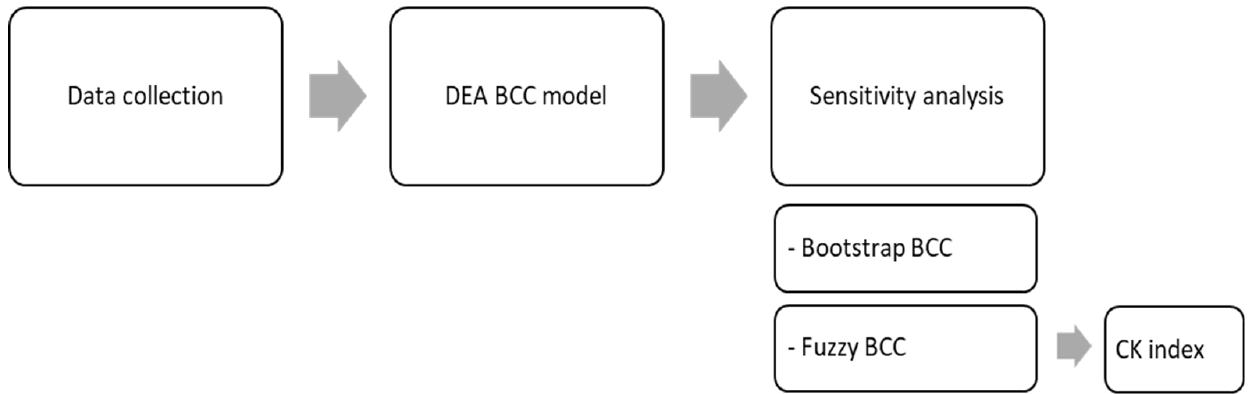
Figure 1. Illustrative flowchart of the methodology.